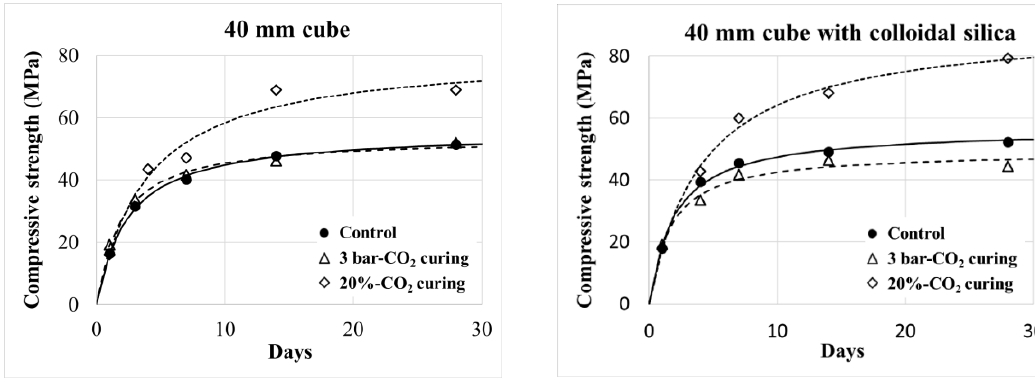
Figure 4. Strength development of Mortar (W/C = 0.5).